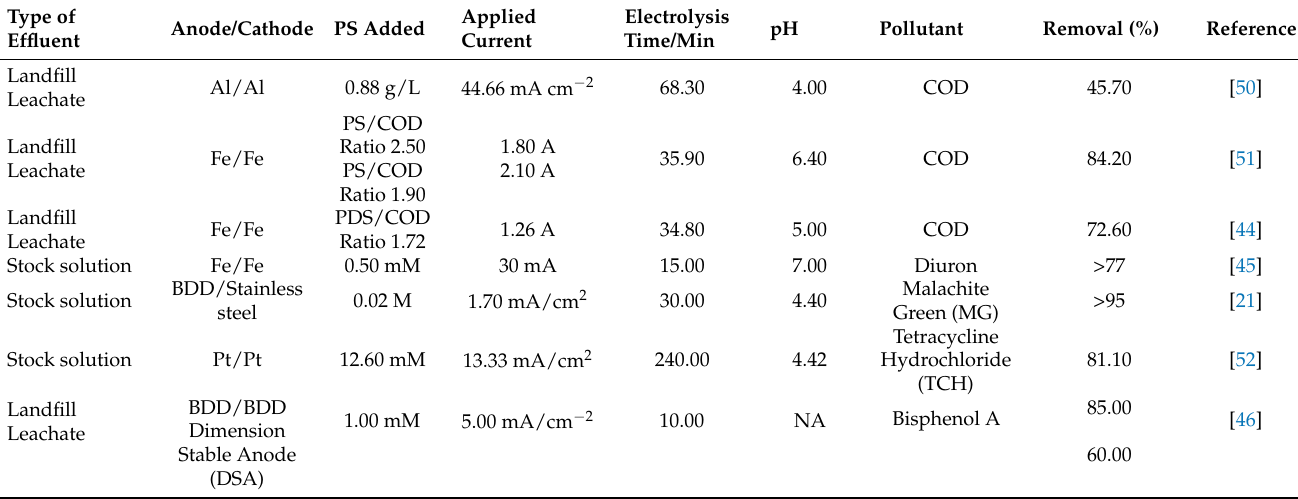
Figure 3. Scheme of the main reactions involved in the persulfate electrochemical production and activation (modified based on [47]). Table 1. Summary of research results previously reported for persulfate electrochemical